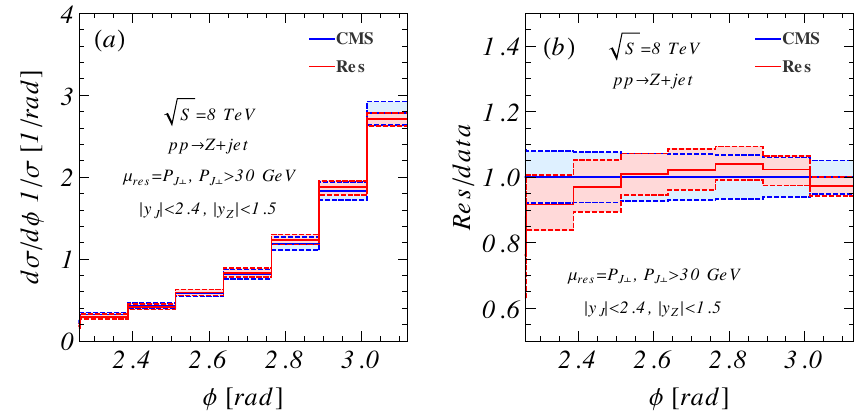
Figure 2. The normalized distribution of φ , the azimuthal angle between the final state jet and Z boson measured in the laboratory frame, for pp > 30 GeV. The blue and red bands represent the CMS experimental error [10] and resummation scale and P J ⊥ uncertainty